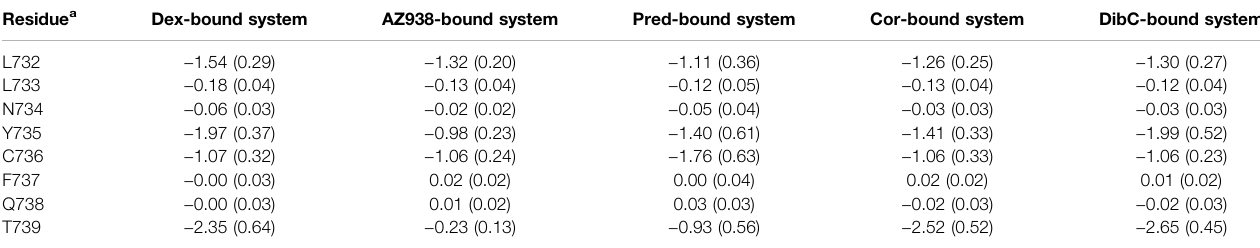
TABLE 2 | Free energy contribution (kcal/mol) by residue and the corresponding free energy difference of H10.